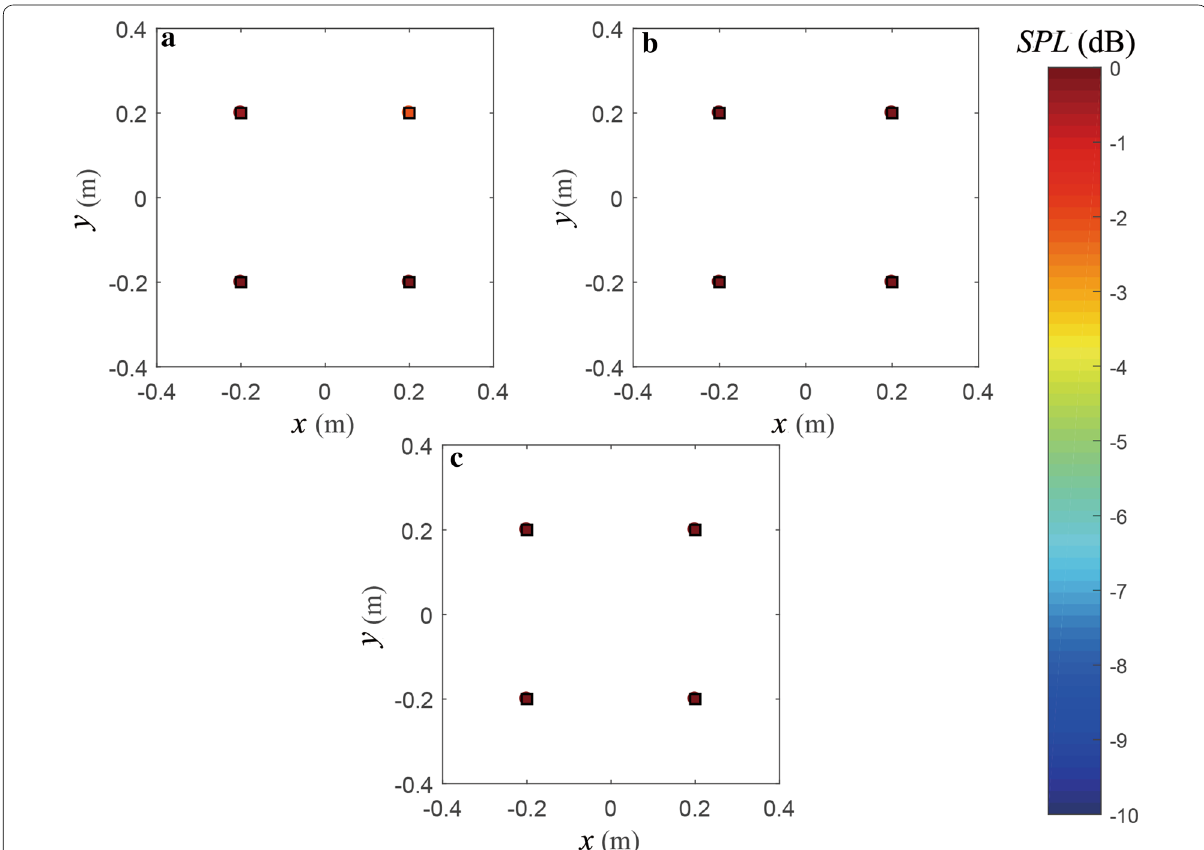
Table 1 OASPL error ratio among each source (%) Reconstructed source S1 S2 S3 BP